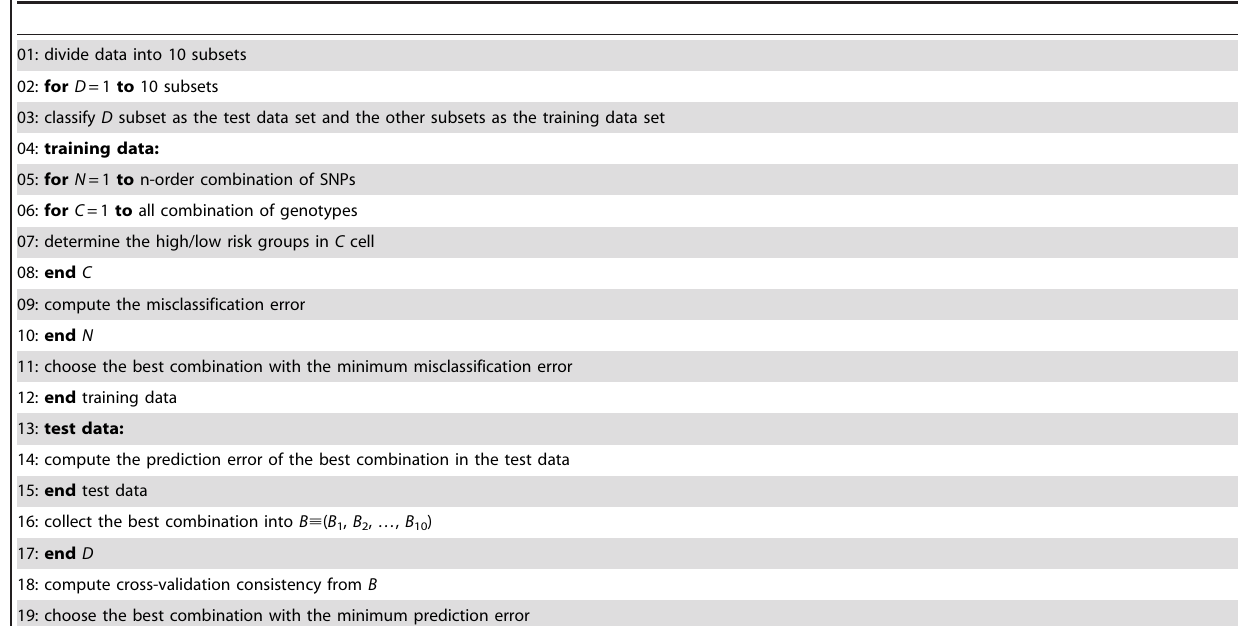
Table 1. MDR pseudo-code.